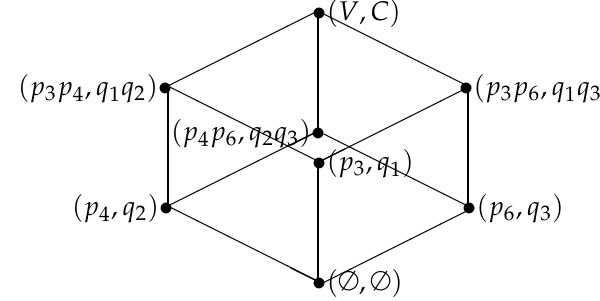
) Figure 2. The Hasse diagram of O ( V , C , I V C V C ) . × ×